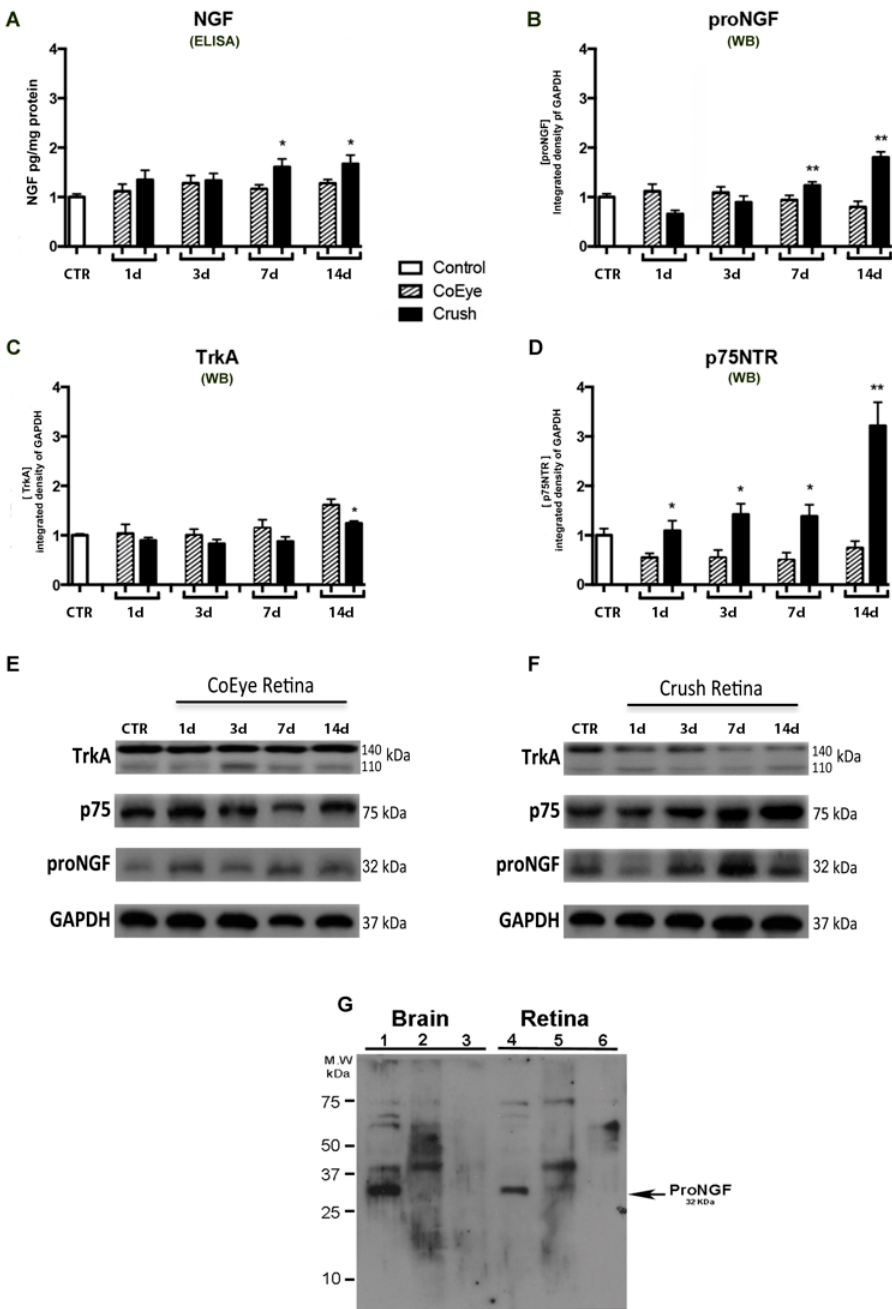
Figure 1. ( A – G ) Biochemical analysis of NGF, TrkA and p75 NTR in the retina from 1 to 14 days after crush ( n = 6 per group). Crush retinas had increased levels of NGF anylate measured by Elisa ( A ) and proNGF quantified by WB analysis ( B ) at 7 d and 14 d. TrkA expression was reduced in Crush retinas at 14 d ( C ) while p75 NTR expression was increased in Crush retinas at all time points analyzed ( D ). Representative images of the WB of the time course in CoEye ( E ) and crushed retina ( F ). ( G ) The specificity of proNGF signal detected in both brain and retinal lysates using anti-proNGF by Alomone (Lanes 1 and 4). No specific signal was found in naïve samples (non reduced and denatured; Lanes 2 and 5), and by pre-incubation with the control peptide provided by Alomone (Lanes 3 and 6). * p < 0.05, ** p < 0.01. WB: Western blot; CoEye: contralateral eye; 1–14 d: 1 to 14 days after crush.